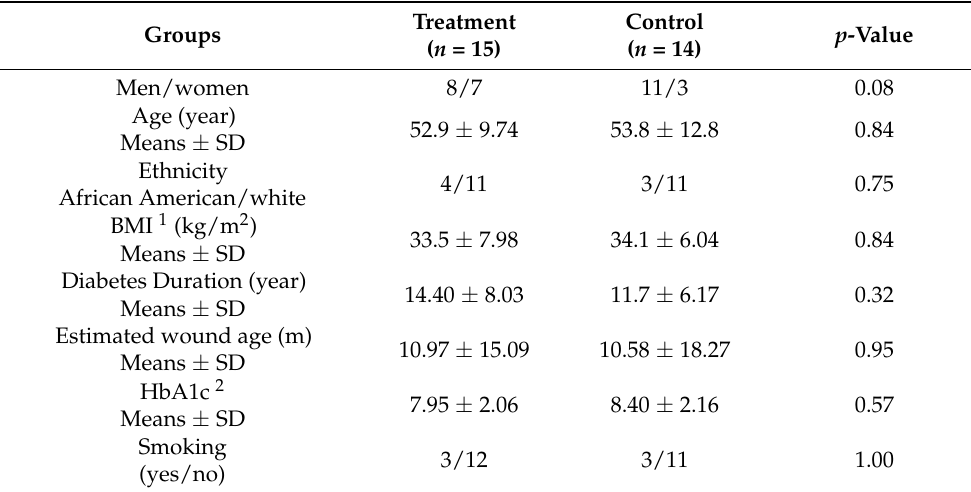
Table 2. Baseline characteristics of participants by group.